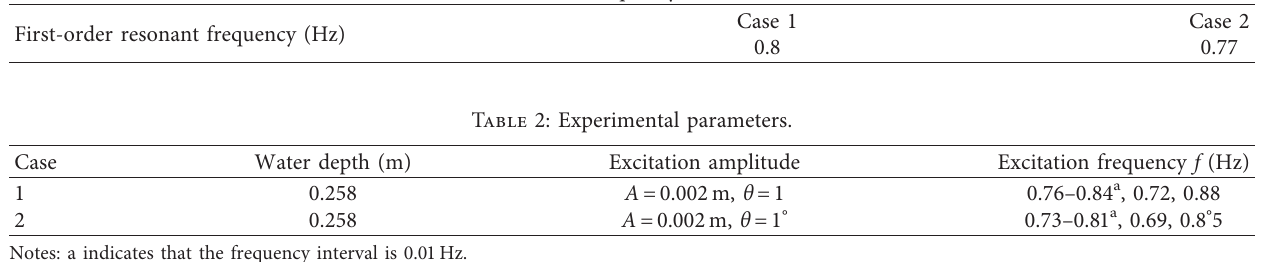
Table 1: The first-order resonant frequency of the tank with different baffles.